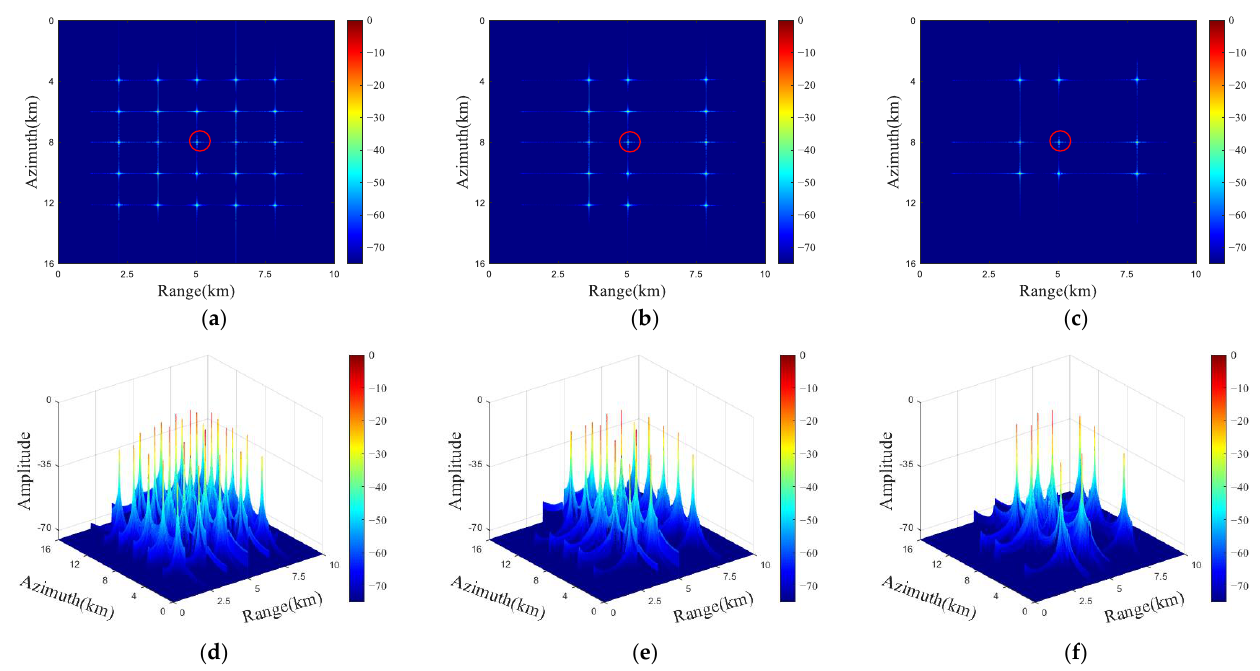
Figure 13. Point target simulation results of CAPII (the real target is inside the red circle). ( a ) Results with intra-pulse and inter-pulse encoding without amplitude encoding. ( b ) The result with amplitude coding values 1, 0, and 1 in the intra-pulse (the amplitude encoding values of inter-pulse are all 1). ( c ) Result with amplitude coding values 1, 0, and 1 in the intra-pulse and inter-pulse. ( d – f ) The 3D imaging results of ( a – c ).